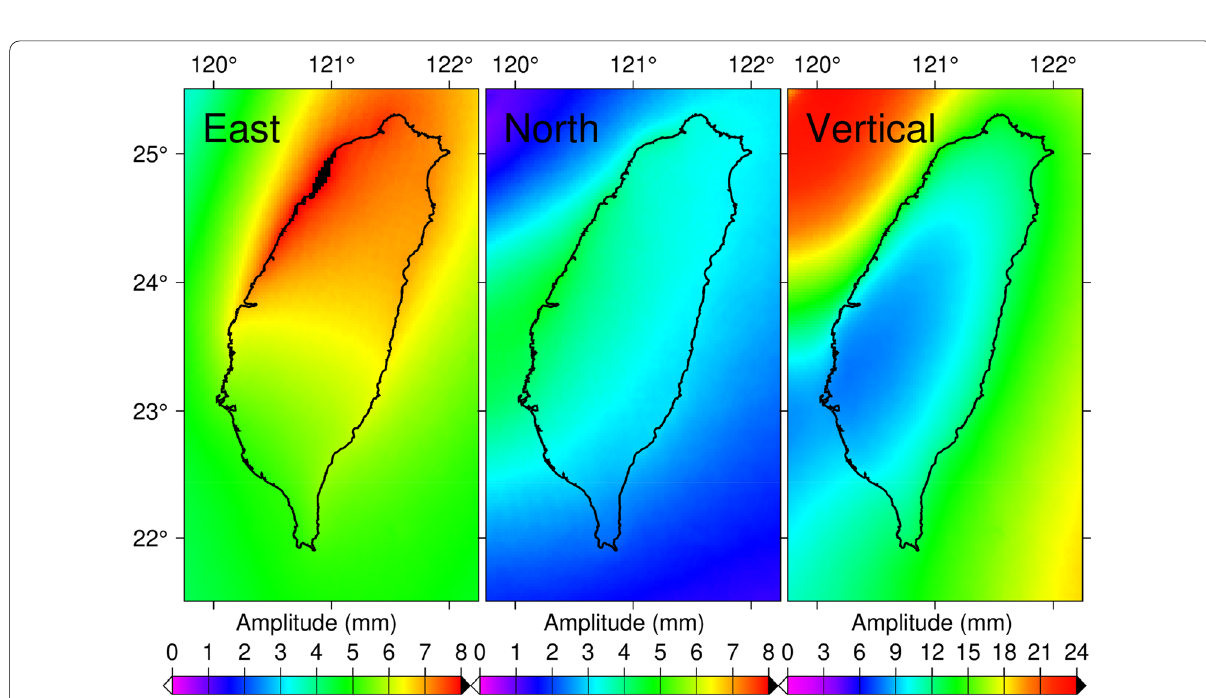
Fig. 6 Modeled OTL displacements for the M 2 tidal harmonic around Taiwan Island. The modeled M 2 OTL displacements for the east component (left), north component (middle), and vertical component (right) are computed based on the FESJB ocean tide model and the TW1 Earth